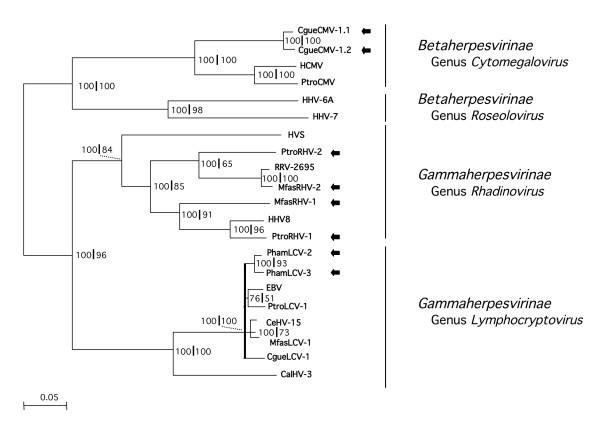
Phylogenetic analysis of the novel primate herpesviruses. A phylogenetic tree was constructed using the amino acid (aa) sequences encoded by the gB-DPOL segments of the novel primate herpesviruses and of known human and non-human primate herpesviruses, available in GenBank. A multiple alignment of concatenated 1100 aa was analysed with the neighbor-joining method. A midpoint-rooted phylogram is shown. The branch length is proportional to evolutionary distance (scale bar). Results of bootstrap analysis (100-fold) are indicated at the nodes of the tree, to the left of the first vertical divider. In addition, the alignment was analysed with Tree-Puzzle 5.0. Support values, estimated by the quartet puzzling (QP) tree search and expressing the QP reliability in percent, are indicated at the nodes of the tree to the left of the vertical divider. Nodes with values below 70% in both analyses were depicted as pat of a multifurcation (black bar). Viruses, which are entirely novel or viruses for which additional sequence information was generated, are highlighted with black arrows. Herpesvirus genera and families are indicated. Full names of known viruses and their nucleotide sequence accession numbers are listed in the Methods section.